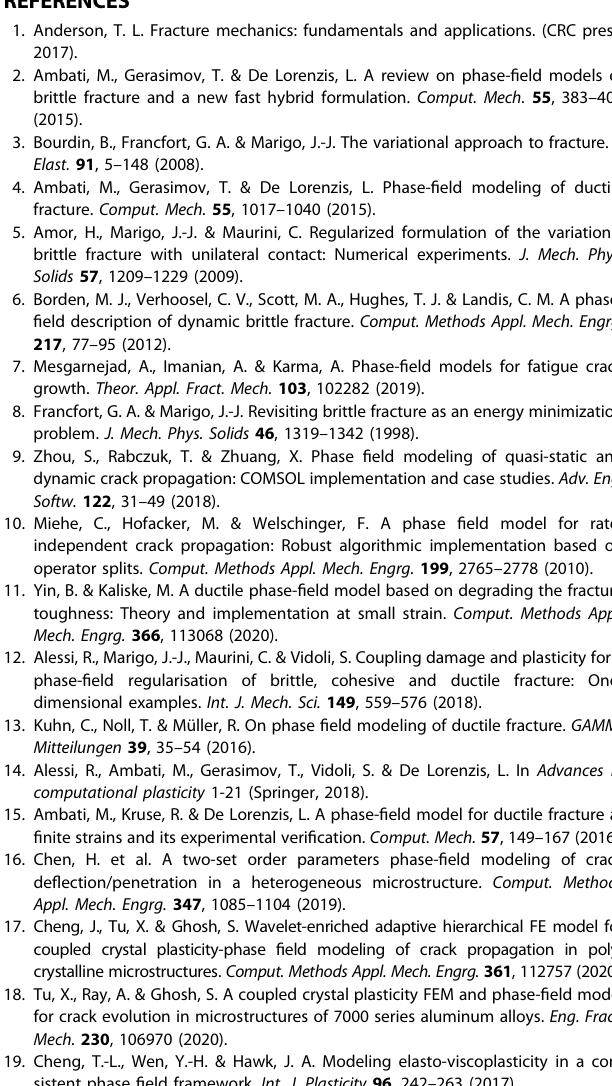
Fig. 10 Magnitude of plastic strain Δ ε p versus cycle number to failure N f . a Results with different initial yield strength σ 0 different values of ε half . The dots denote the results from phase- fi eld simulations, and the dotted lines are fi tted based on the simulation results. The slopes of the fi tted lines are